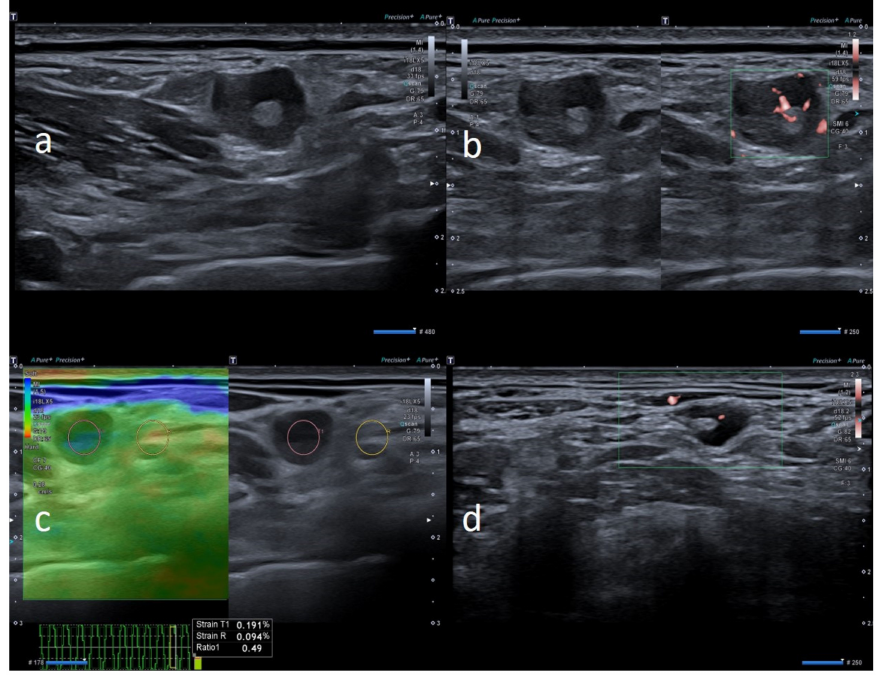
Figure 8. 69-year-old female with palpable unilateral sopraclavicolar adenopathy noted 3 days after receiving the first dose of the AstraZeneca COVID-19 vaccine in her left deltoid muscle. ( a ) B-mode sonogram image shows round lymph node with asymmetric cortical thickening and hilum evidence. ( b ) SMI image shows central and peripheral vascularization. ( c ) Elastonography strain shows similar pattern of the node compared to surrounding tissue. ( d ) After 1 month, the cortical thickening appears uniform, with hilum